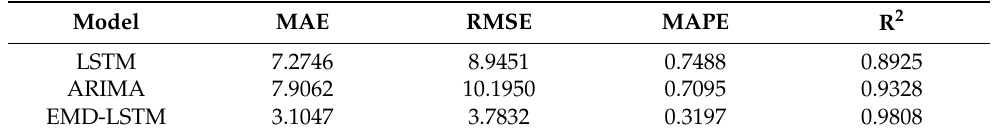
Table 5. Results of stock price prediction from three prediction